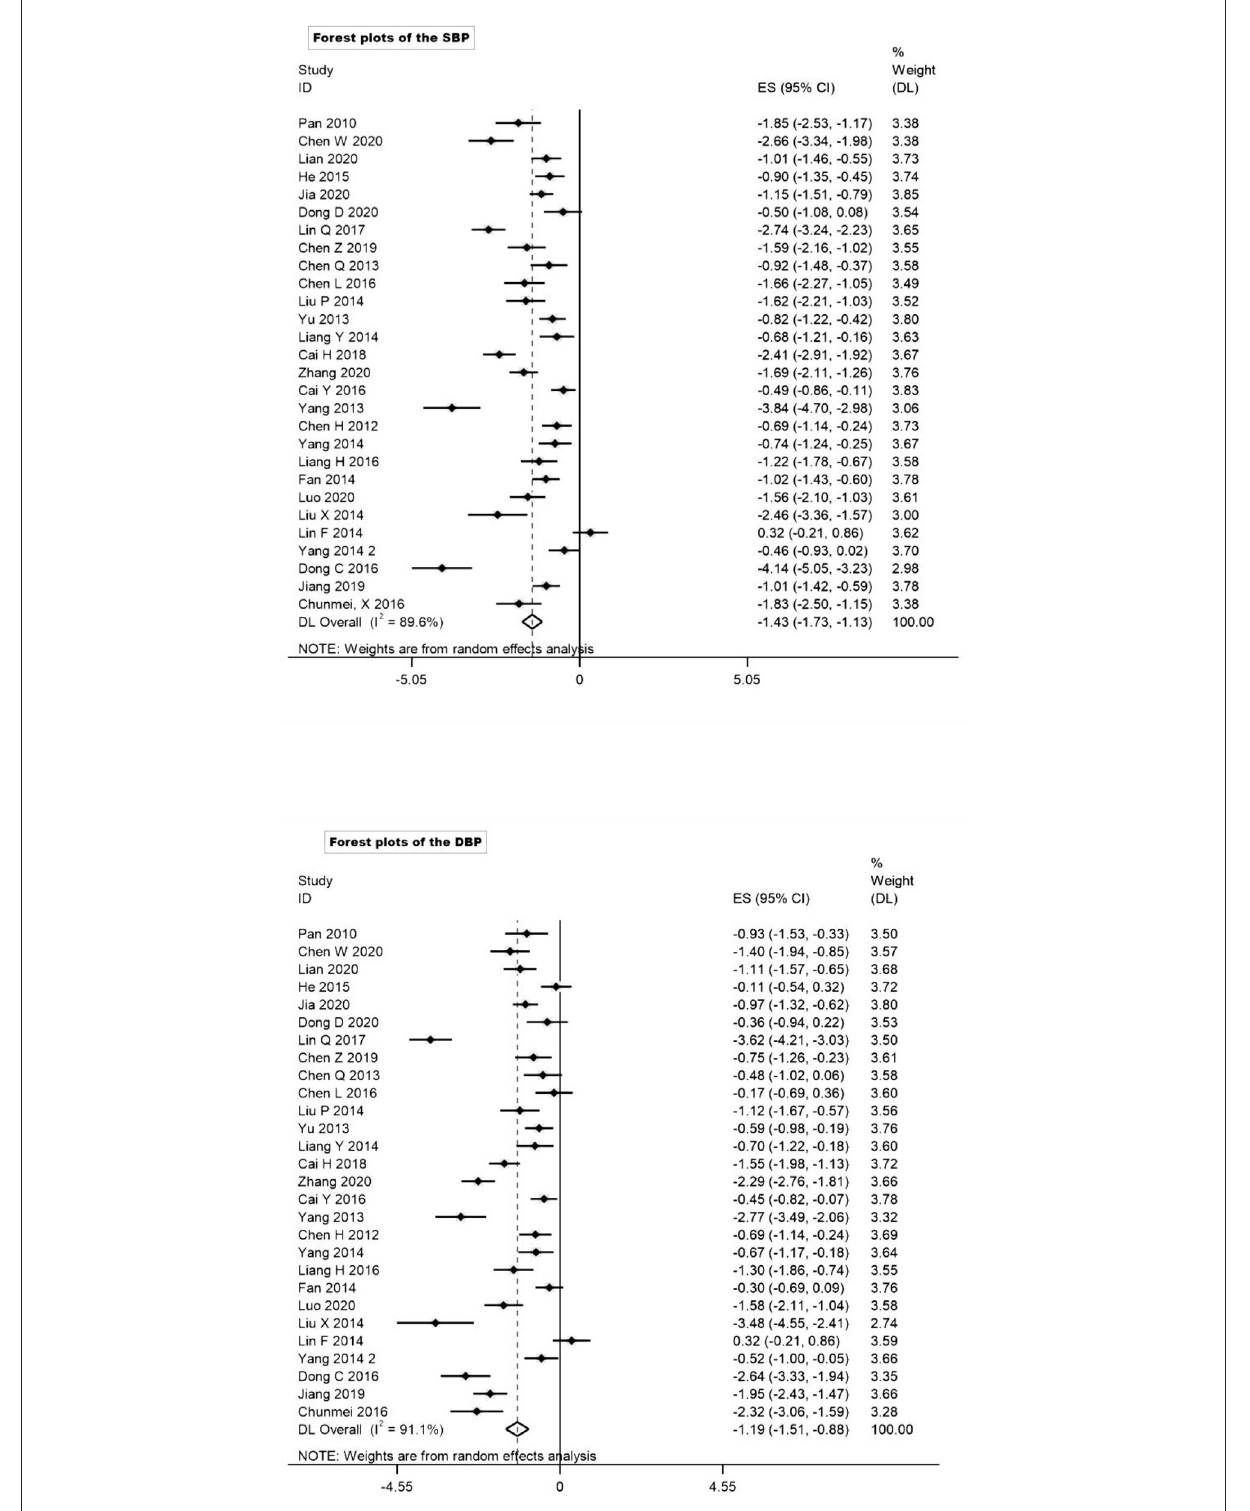
FIGURE2 Age subgroup analysis of SBP and